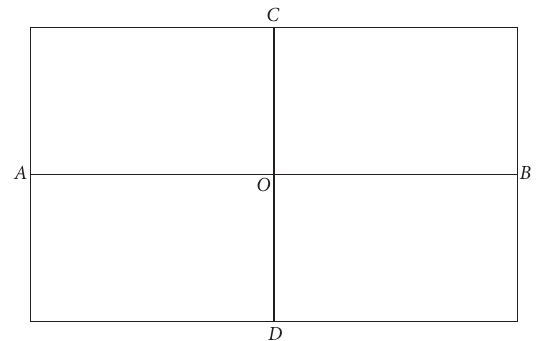
Figure 5: Sketch map of the displacement of tunnel